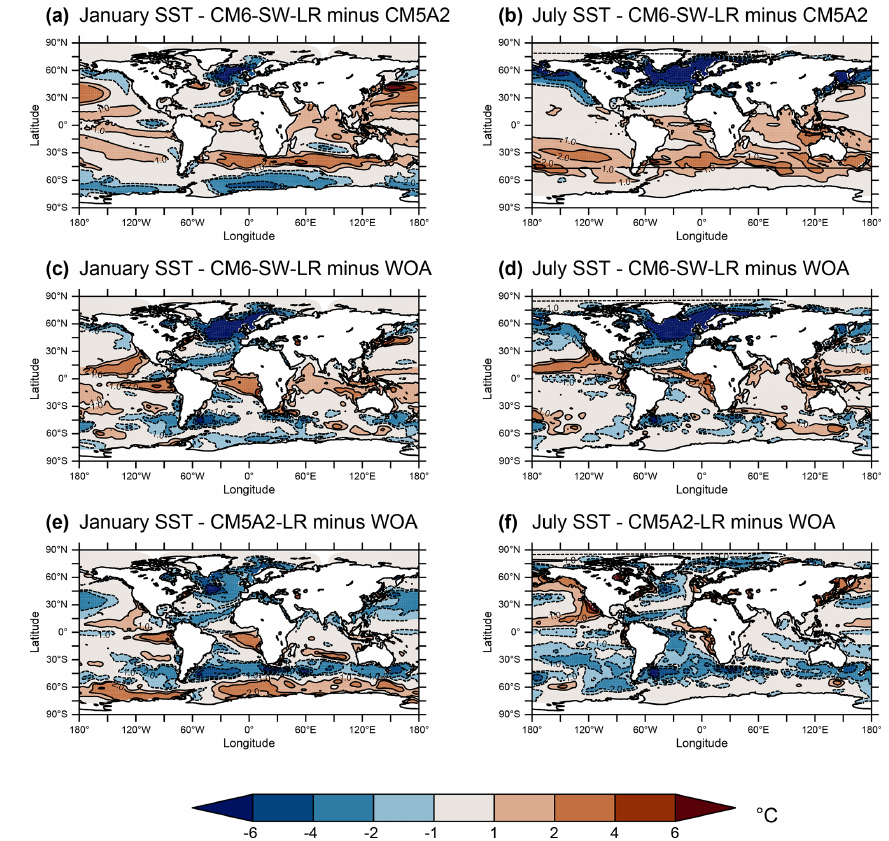
Figure A1. Sea surface temperature (SST) difference between the different versions of IPSLCM and with the World Ocean Atlas. (a, c, e) Jan- uary, (b, d, f) July. (a, b) IPSLCM6-SW-LR minus IPSLCM5A2-LR, (c, d) IPSLCM6-SW-LR minus the World Ocean Atlas (WOA, Lo- carnini et al., 2013), (e, f) IPSLCM5A2-LR minus the World Ocean Atlas. IPSLCM6-SW-LR is averaged over 10 years. IPSLCM5A2-LR is averaged over 100